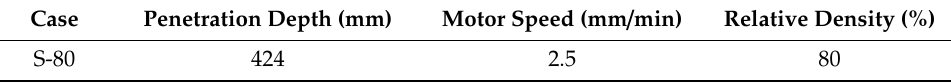
Figure 3. Static loading test concept diagram and cross section diagram. Table 3. Static loading test